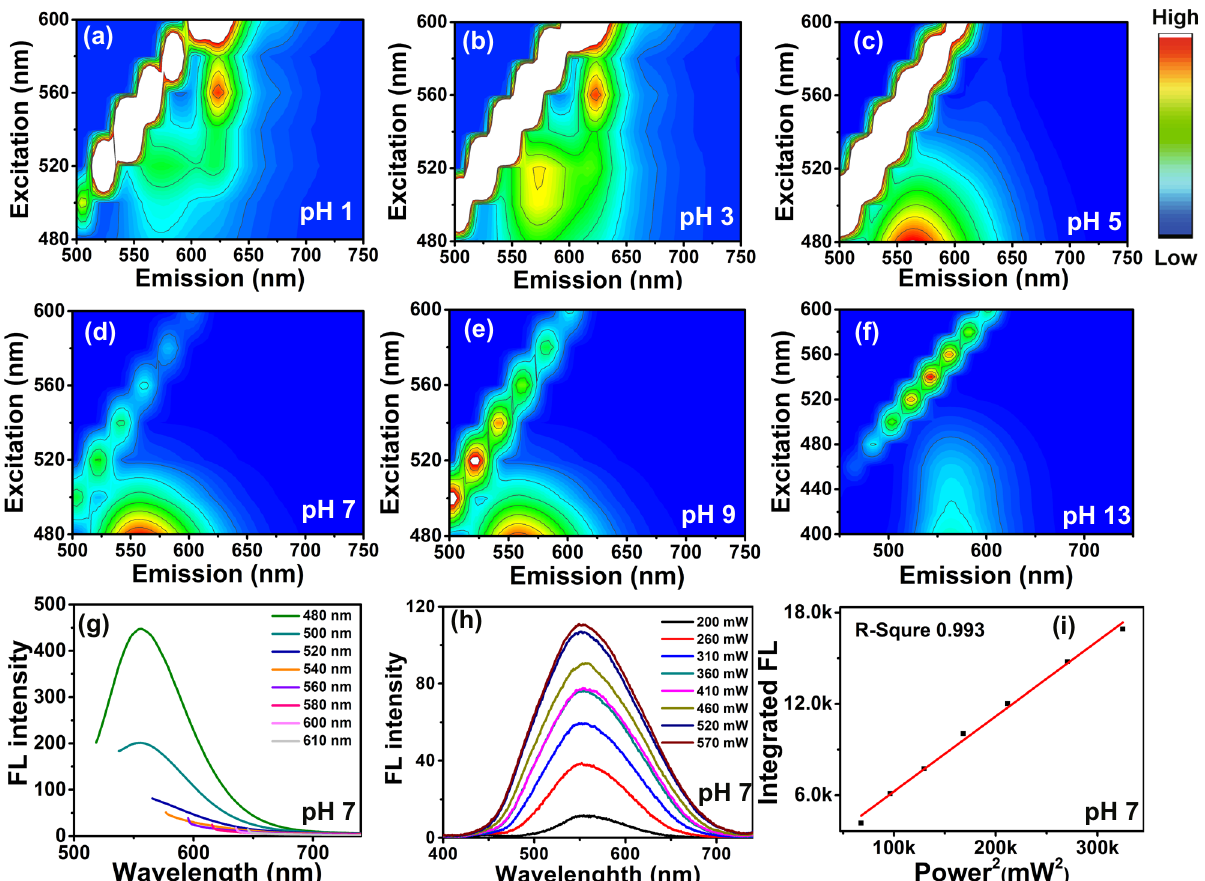
Fig. 2 PL evolution of CDs under variable H + ions concentration. a – f Normalized 3D FL spectra of CDs under different pH condition adjusted by H 2 SO 4 and NaOH; g , h one-photon and two-photon fl uorescence (FL) spectra of CDs without protonation treatment; i relationship of two-photon FL intensity and femtosecond (fs) laser